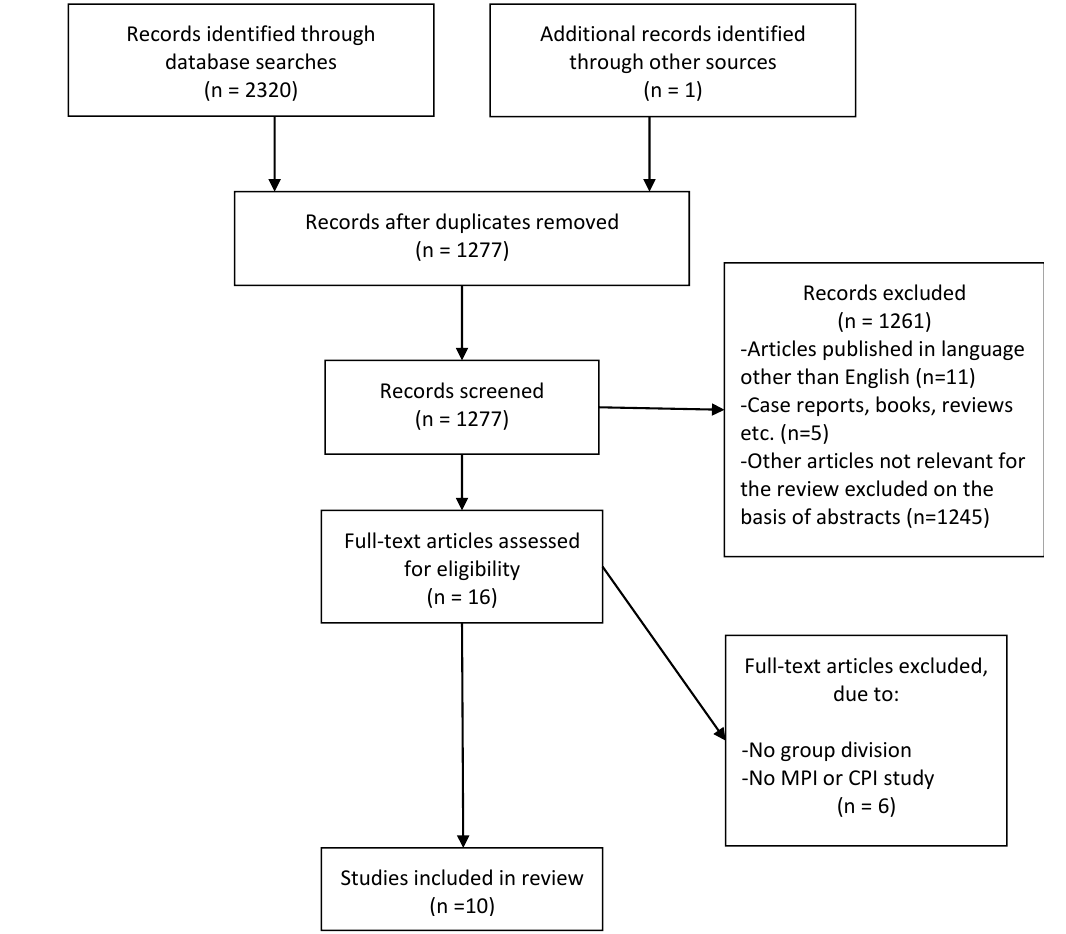
Figure 1. Preferred Reporting Items for Systematic Reviews and Meta-Analysis (PRISMA) search strategy flowchart. MPI = mandibular position indicator; CPI = condylar position indicator.